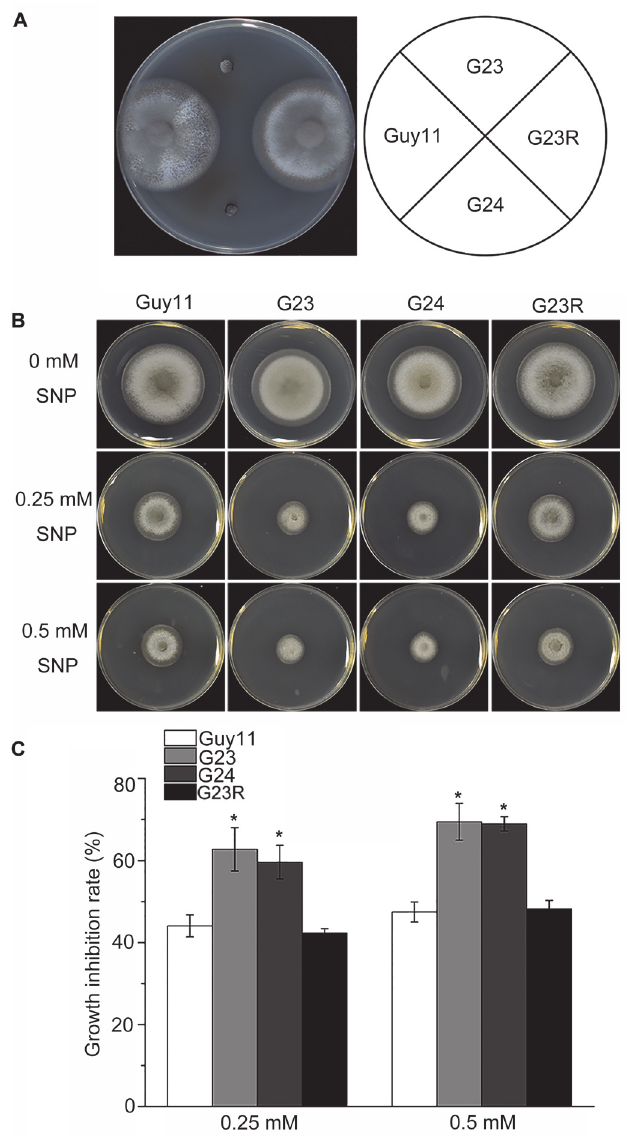
Fig 2. Effect of formaldehyde and SNP on vegetative growth of the tested M . oryzae strains. (A) M . oryzae strains were cultured on CM containing 0.3 mM formaldehyde at 28°C for 6 days. (B) Vegetative growth of Guy11, MoSFA1 deletion and reintroduction mutants were grown on CM containing 0.25 or 0.5 mM SNP at 28°C for 6 days. (C) Colony diameters of the tested strains were measured and Growth inhibition rate were evaluated. The experiments were performed in triplicate. ANOVA analysis was performed after growth inhibition rate were arcsine transformed. However, the original percentages were used for presentations. Error bars represent SD of the original percentages. Asterisks in each data column indicate significant differences at p = 0.05.